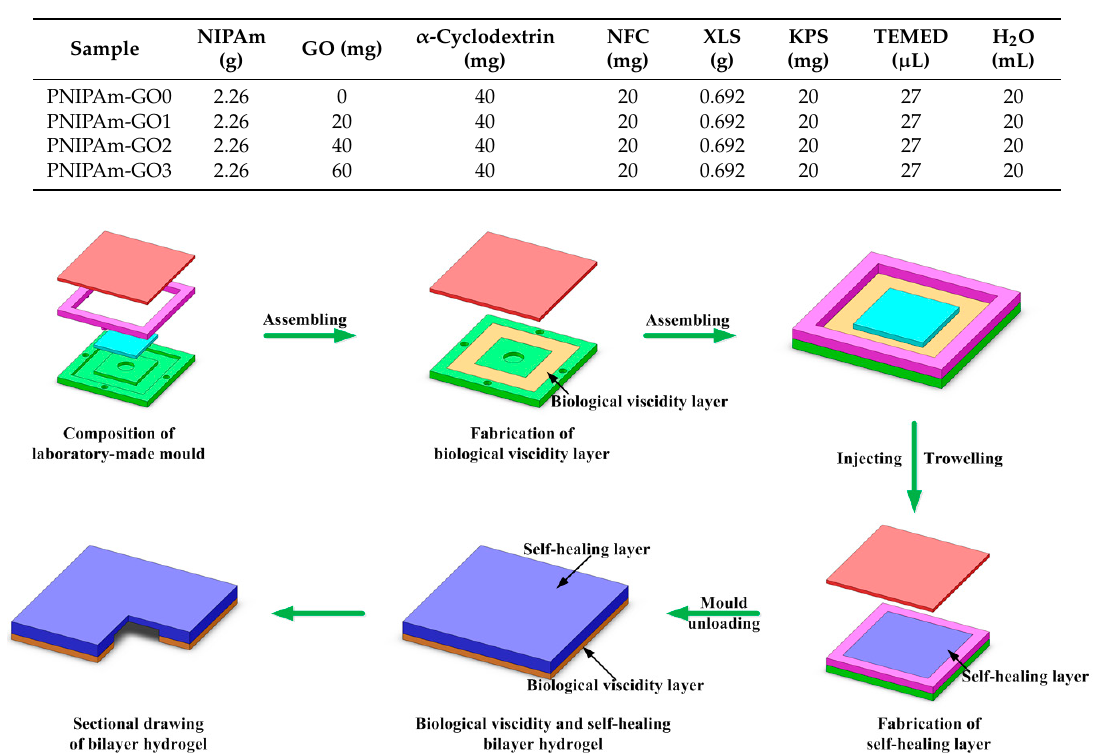
Figure 1. Schematic of the mold and fabrication process of bilayer hydrogel systems.